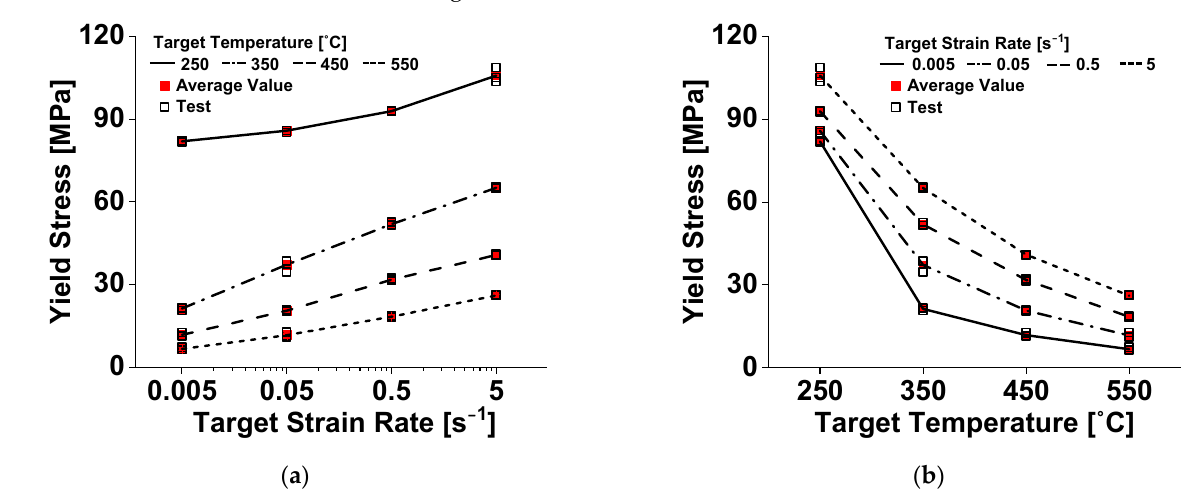
Figure 3. Compressive yield stress of Al 6063 alloy dependent on: ( a ) strain rate; and ( b ) temperature.